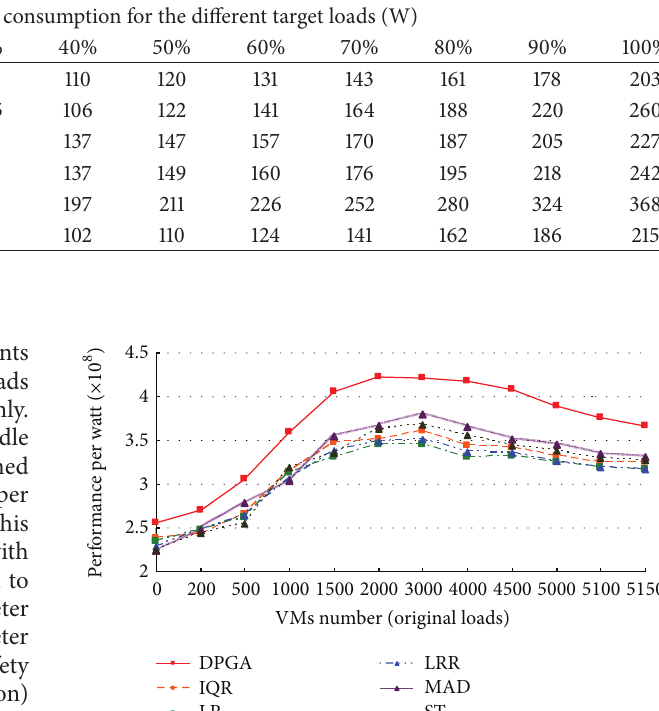
Table 3: Benchmark results summary of host models.